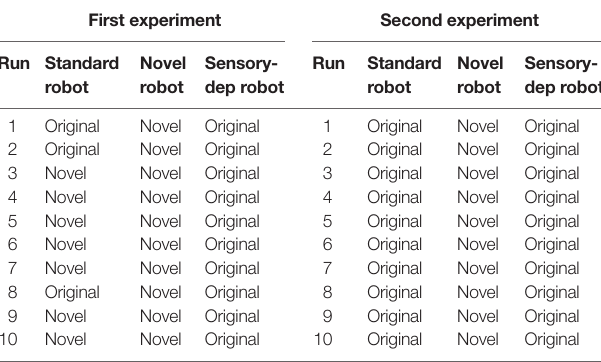
TaBle 2 | The robots’ choices between the novel and the original resource in the first (left) and the second part (right) of the learning